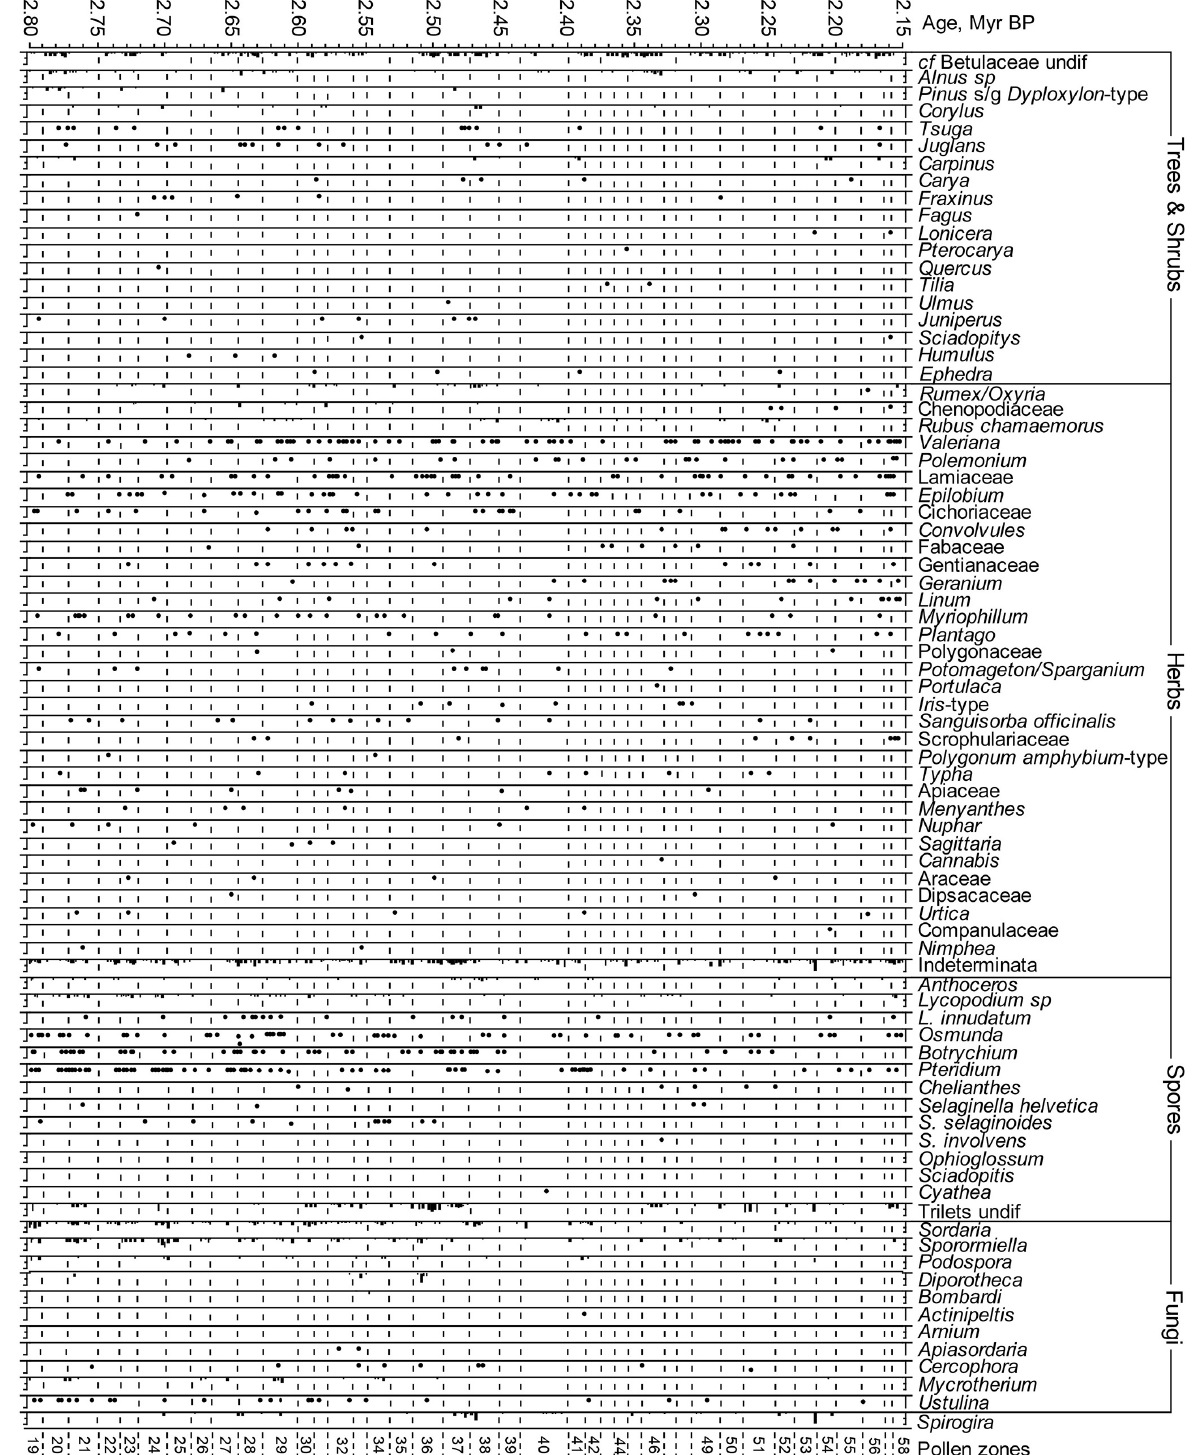
Figure 3d. Percentage pollen, spore, and non-pollen-palynomorph diagram. The minor pollen and spores types between ca. 2.8 and 2.15Myr